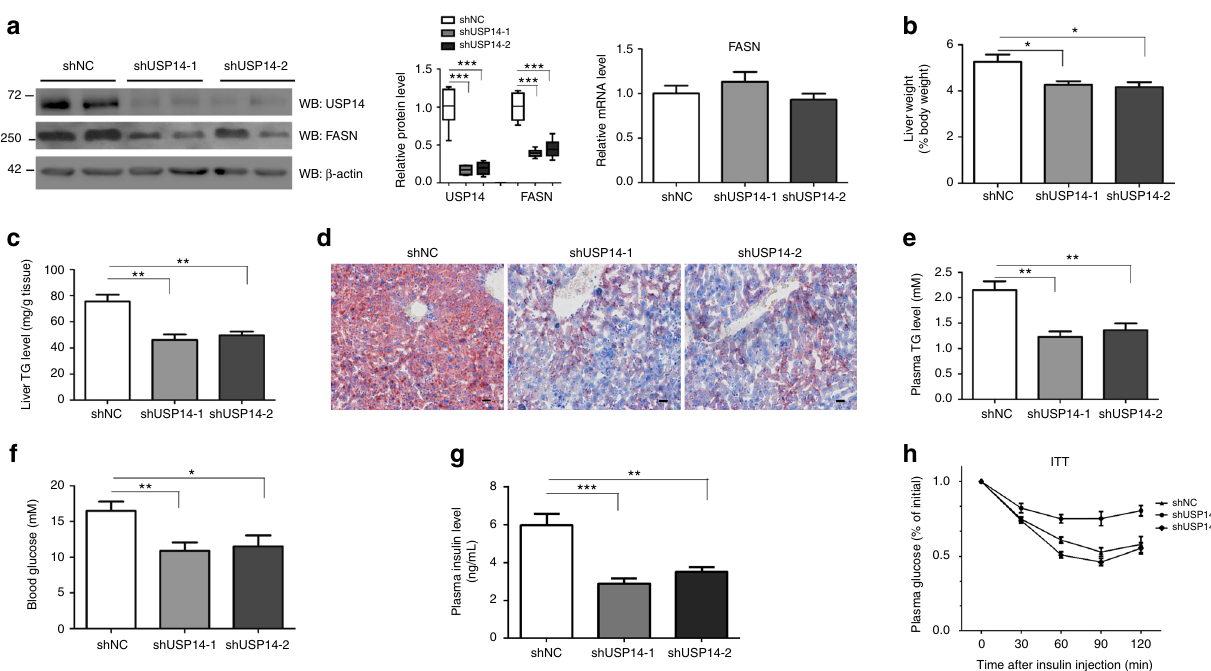
Fig. 7 Knockdown of USP14 improves hepatosteatosis in db/db mice. a Hepatic USP14 protein (left) and mRNA (right) levels in db/db mice. Mice were administered with adenoviral shRNAs targeting USP14 or NC via tail vain injection. ( n = 8 for each group). A representative western blot was shown with the quanti fi cation plot based on scanning densitometry analysis. The two lanes are two representative biological replicates. Each lane represents the tissue protein sample from one mouse. *** p < 0.001 versus indicated groups (Student ’ s t -test). b , c Liver weight b , hepatic TG contents c in db/db mice infected with shNC and shUSP14. d Representative hepatic histology by Oil Red O staining from db/db mice, scale bar 100 μ m. e Plasma TG levels in two groups of mice. f – h Blood glucose and insulin levels and insulin tolerance tests in db/db mice. After a 16-h fast, mice were killed at day 12. Data are presented